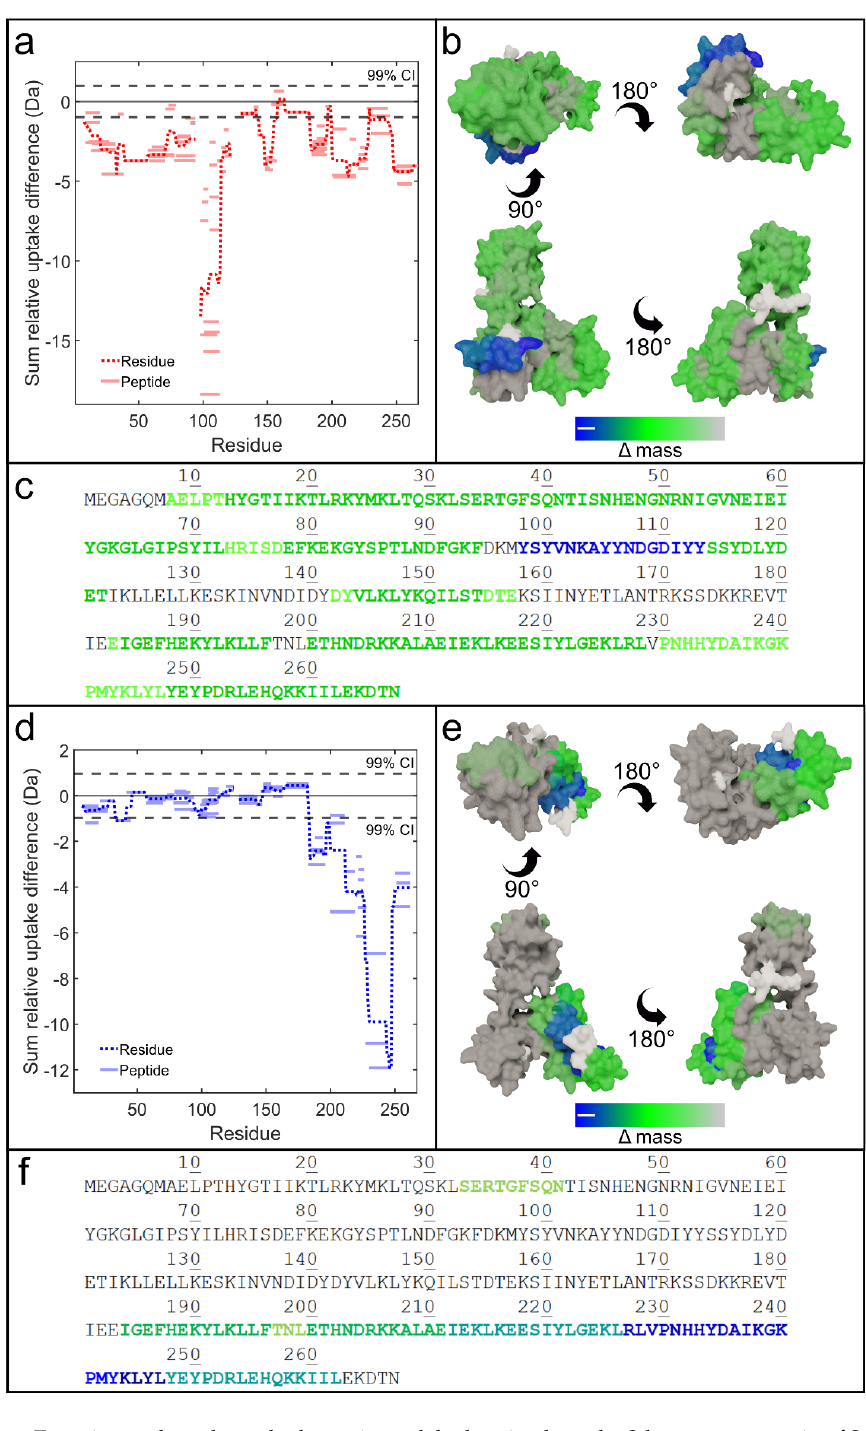
Figure 5. Experimental results and schematic models showing how the Stl repressor protein of SaPIbov1 interacts with drastically di ff erent families of phage dUTPases. ( a , d ) HDX di ff erence plots showing the ∆ mass of each peptide (solid lines) as well as the average amount per residue (dotted lines) of Stl upon mixing with DUT ϕ 11 (a) and DUT ϕ NM1 (d). The dashed lines represent the 99% confidence bands evaluated over the whole dataset. ( b , e ) Homology model of Stl colored according to the HDX-MS di ff erence data obtained upon binding to DUT ϕ 11 (b) and DUT ϕ NM1 (e), following the color gradient shown at the bottom of the panel (views: top, bottom, sides). Regions which could not be probed by HDX-MS are shown in white. ( c , f ) Sequence of Stl is shown with letter coloring according to HDX di ff erence data when bound to DUT ϕ 11 (c) and DUT ϕ NM1